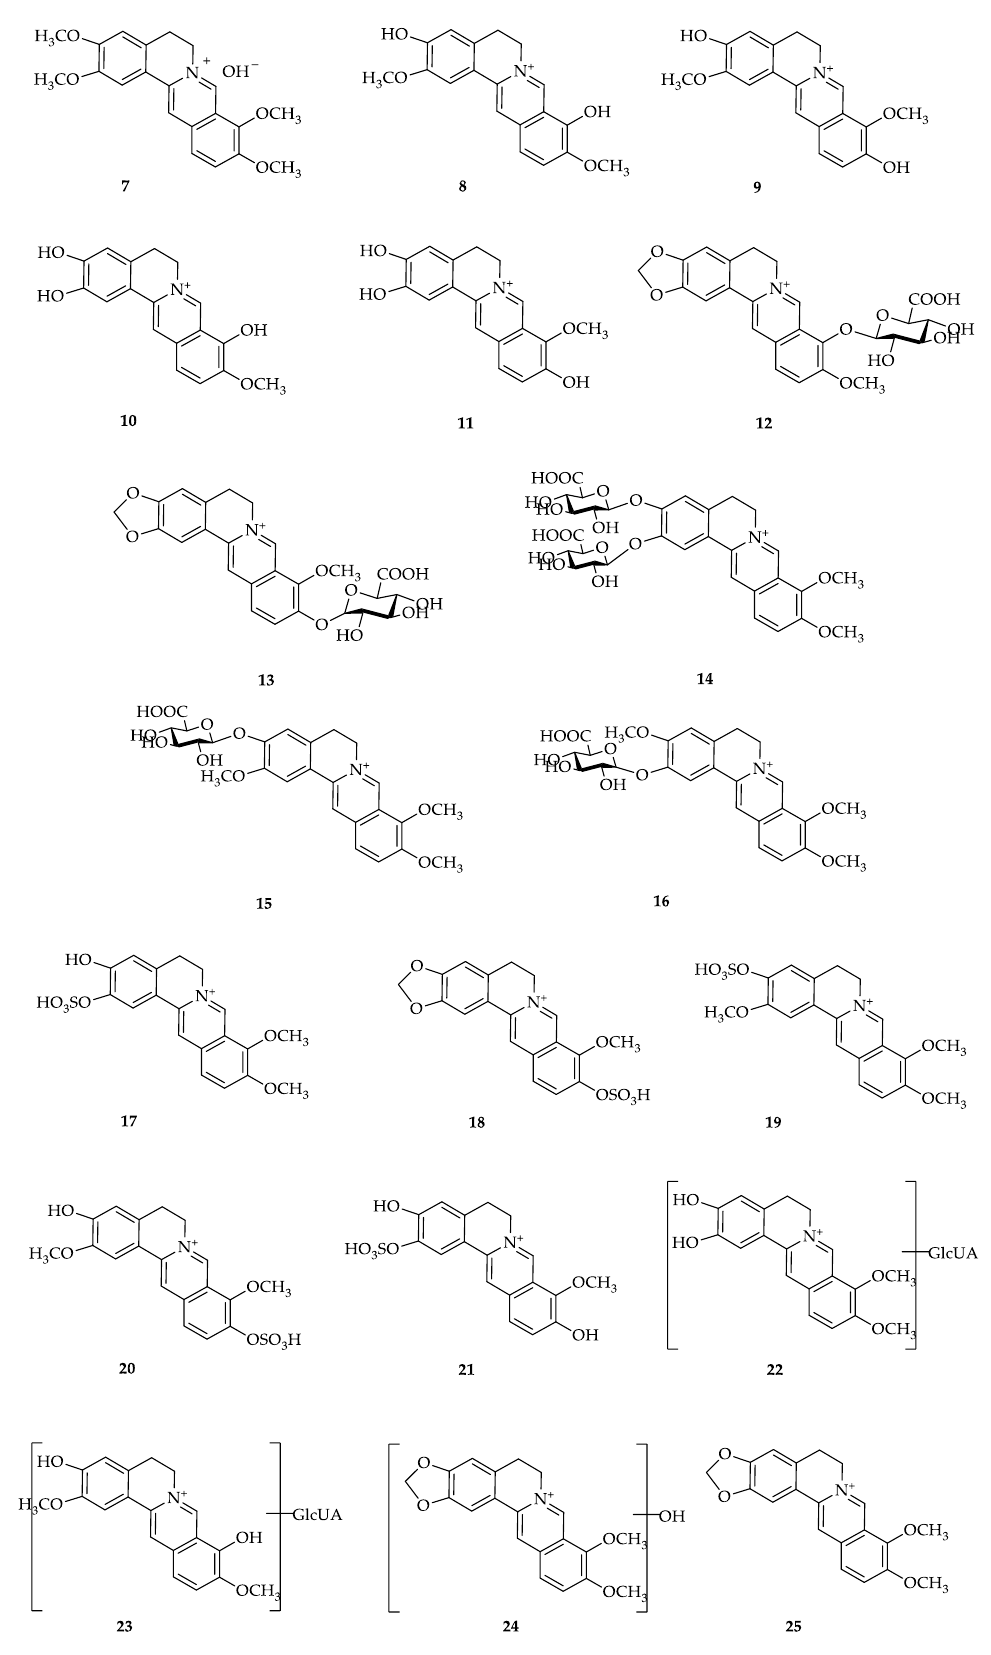
Figure 2. Structures of berberine and its metabolites. ( 1 ) Berberine; ( 2 ) berberrubine; ( 3 ) thalifendine; ( 4 ) demethyleneberberine; ( 5 ) jathorrhizine; ( 6 ) columbamine; ( 7 ) palmatine; ( 8 ) 3,9-demethylpalmatine; ( 9 ) 3,10-demethylpalmatine; ( 10 ) 2,3,9-trihydroxiberberine; ( 11 ) 2,3,10- trihydroxiberberine; ( 12 ) berberrubine-9- O - β - D -glucuronide; ( 13 ) thalifendine-10- O - β - D - glucuronide; ( 14 ) demethyleneberberine-2,3-di- O - β - D -glucuronide; ( 15 ) jatrorrhizine-3- O - β - D - glucuronide; ( 16 ) columbamine-3- O - β - D -glucuronide; ( 17 ) demethyleneberberine-2- O -sulfate; ( 18 ) thalifendine-10- O -sulfate; ( 19 ) jatrorrhizine-3- O -sulfate; ( 20 ) 3,10-demethylpalmatine-10- O -sulfate; ( 21 ) 2,3,10-trihydroxyberberine-2- O -sulfate; ( 22 ) glucuronide of demethyleneberberine; ( 23 ) glucuronide of 3,9-demethylpalmatine; ( 24 ) hydroxylated berberine; ( 25 ) dihydroberberine [40].